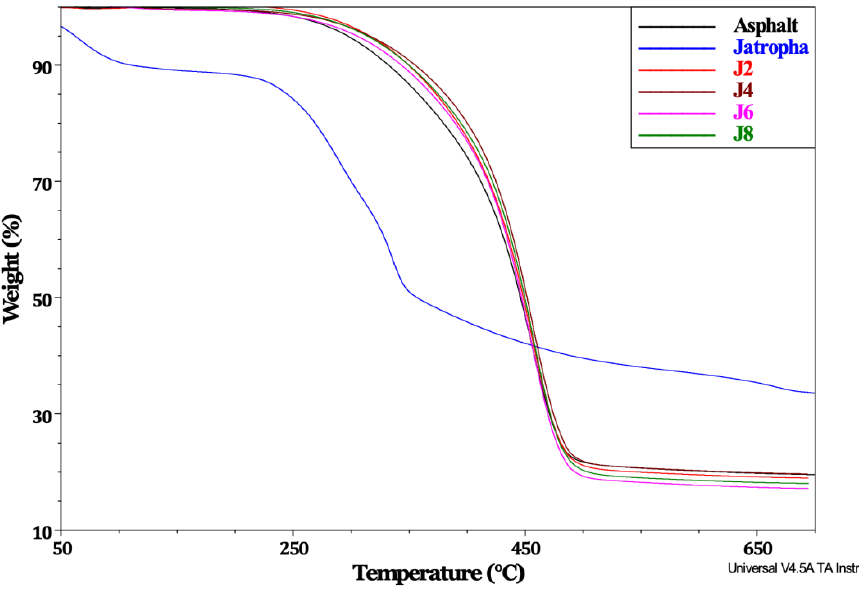
Figure 7. TGA thermograms of asphalt, Jatropha curcas , and modified asphalt mix with Jatropha curcas seed shells.